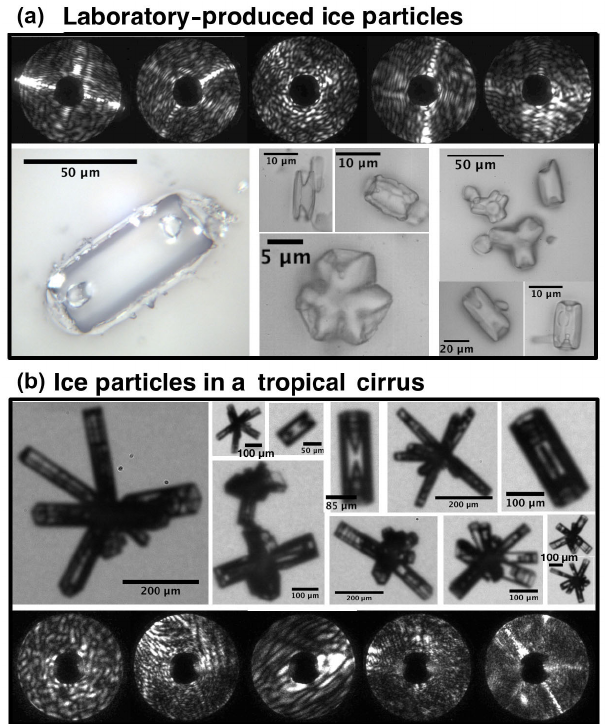
Figure 1. Hexagonal ice crystals and 2-D diffraction patterns mea- sured in laboratory simulations at − 50 ◦ C (a) and in tropical cirrus at − 60 ◦ C (b) . The microscopic images of the laboratory-produced ice crystals are from ice crystal replicas and the tropical cirrus ice particles were imaged in flight using bright field microscopy. The 2- D diffraction patterns were measured simultaneously from the same particle